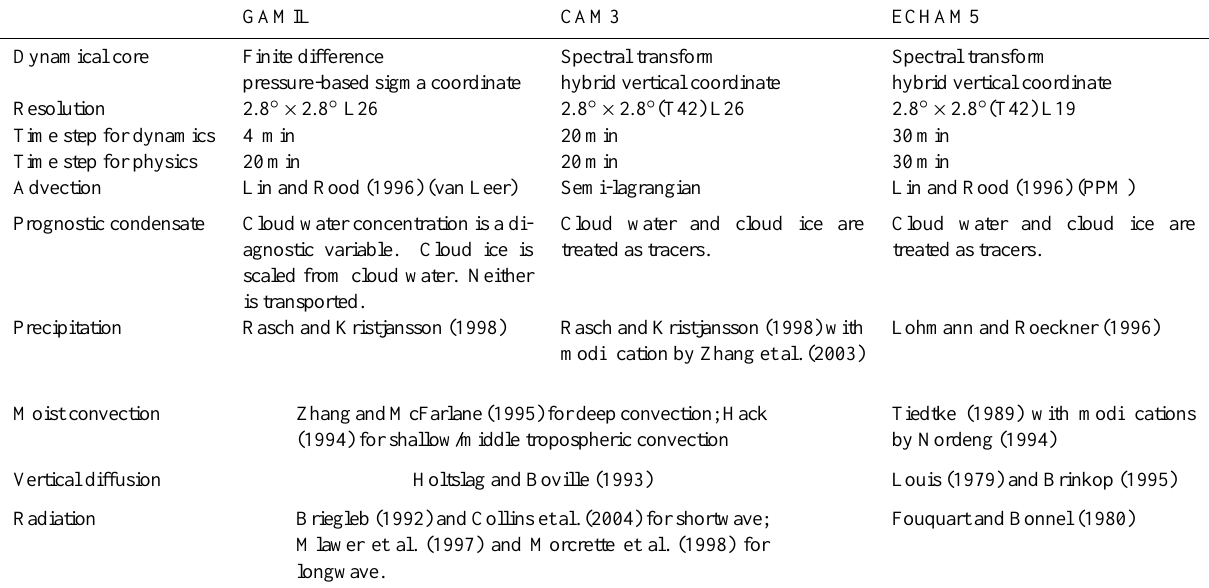
Table 1. Summary of the main features of the three AGCMs used in this study. GAMIL CAM3 ECHAM5 Dynamical core Finite difference Spectral transform Spectral transform